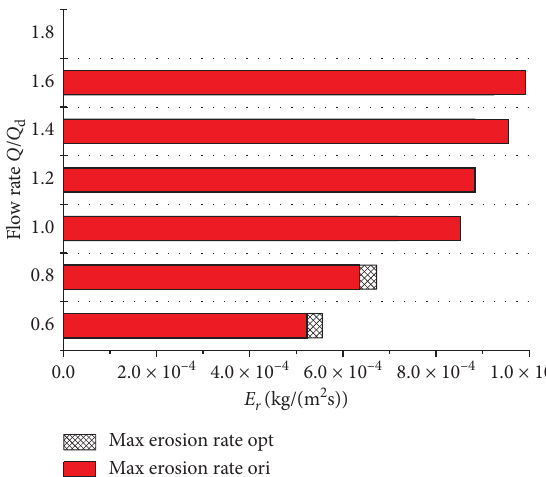
Figure 11: Comparison of average shear stress before and after optimization.